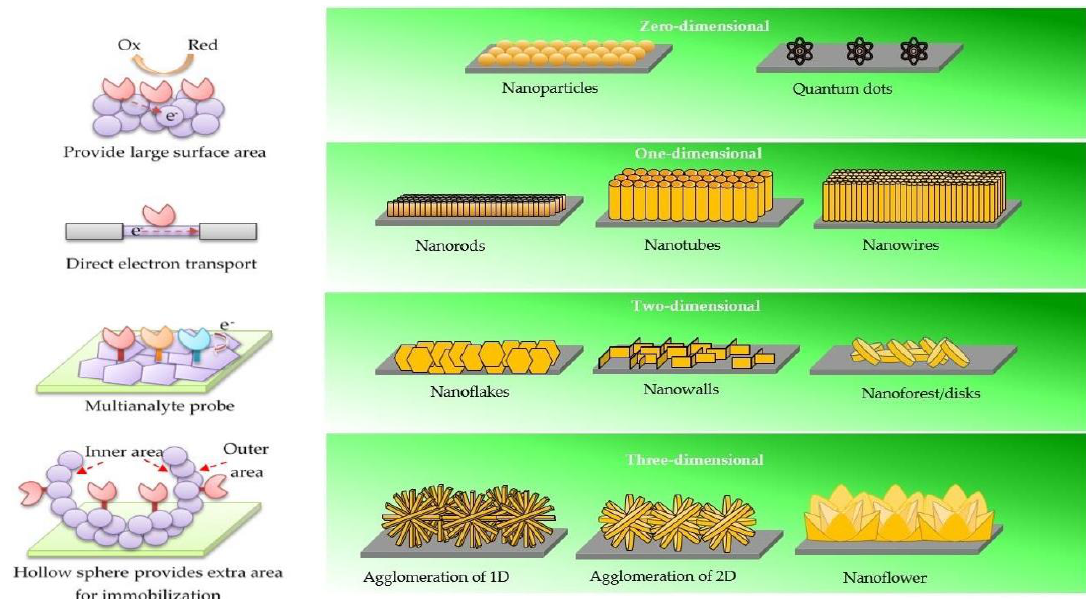
Figure 1. Four di ff erent dimensions of ZnO nanostructures with their advantages. 0-D nanostructures provide large surface area. 1-D nanostructures possess stable and direct electron transport. 2-D nanostructures give specific planes for immobilization process for the simultaneous detection of di ff erent analytes. 3-D nanostructures have extra surface area (outer and inner area) to provide more sites for immobilization.